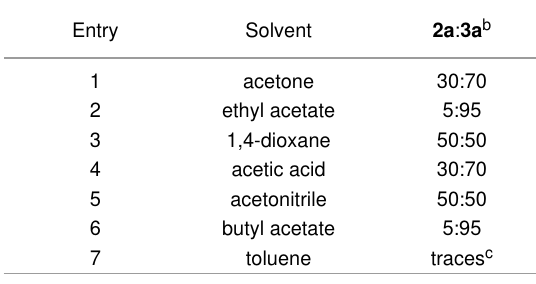
Table 1: Reaction of FPD 1a with thiourea at room temperature in various solvents. a